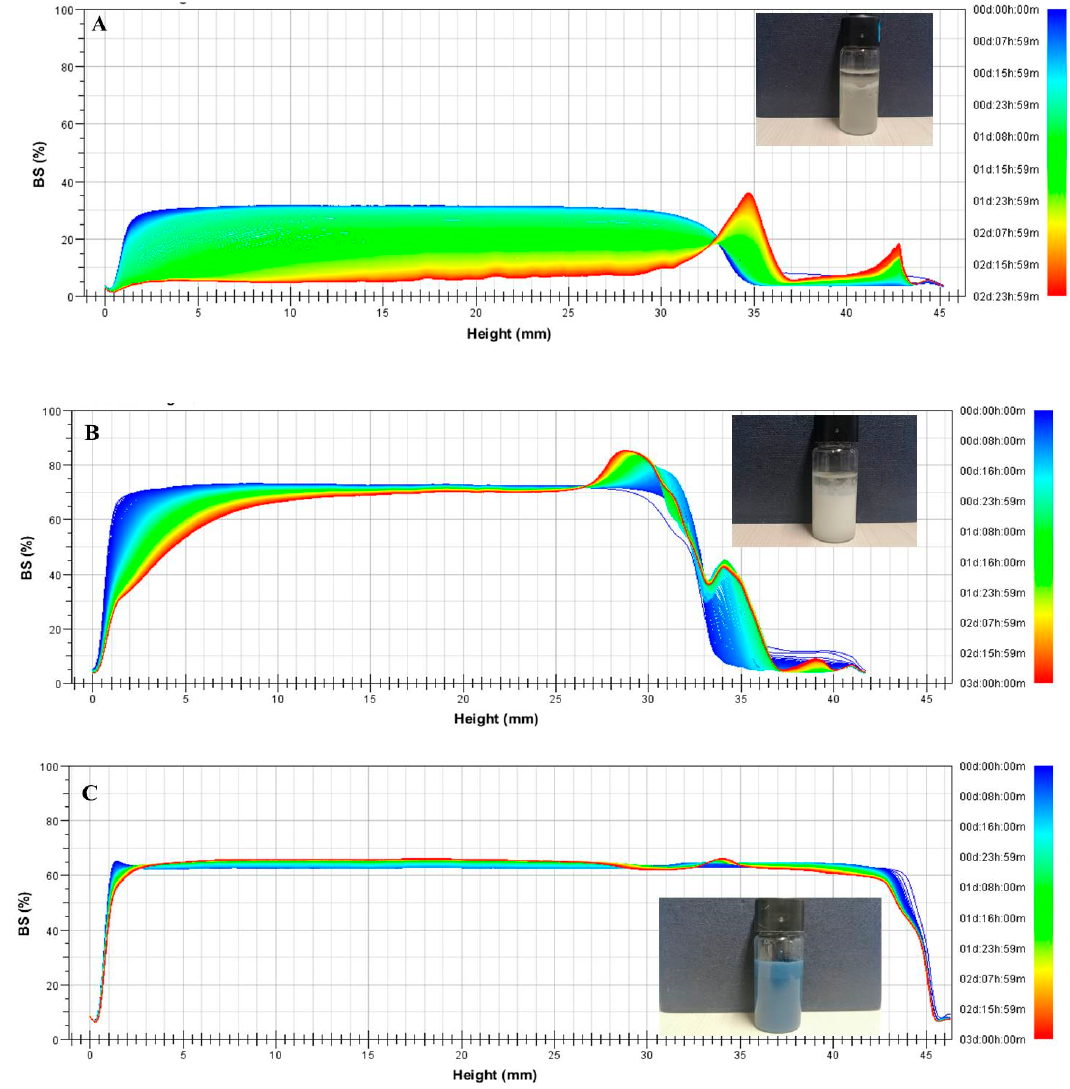
Figure 5. Changes in the backscattering intensity (BS) profiles of oil-in-water (O / W) emulsions generated by gelatin enzymic digest (GED) ( A ), tannic acid-induced gelatin hydrolysate (GED-TA) ( B ), and GP-GED-TA ( C ). The inserted photographs were taken 3 days after preparation of fresh emulsions.